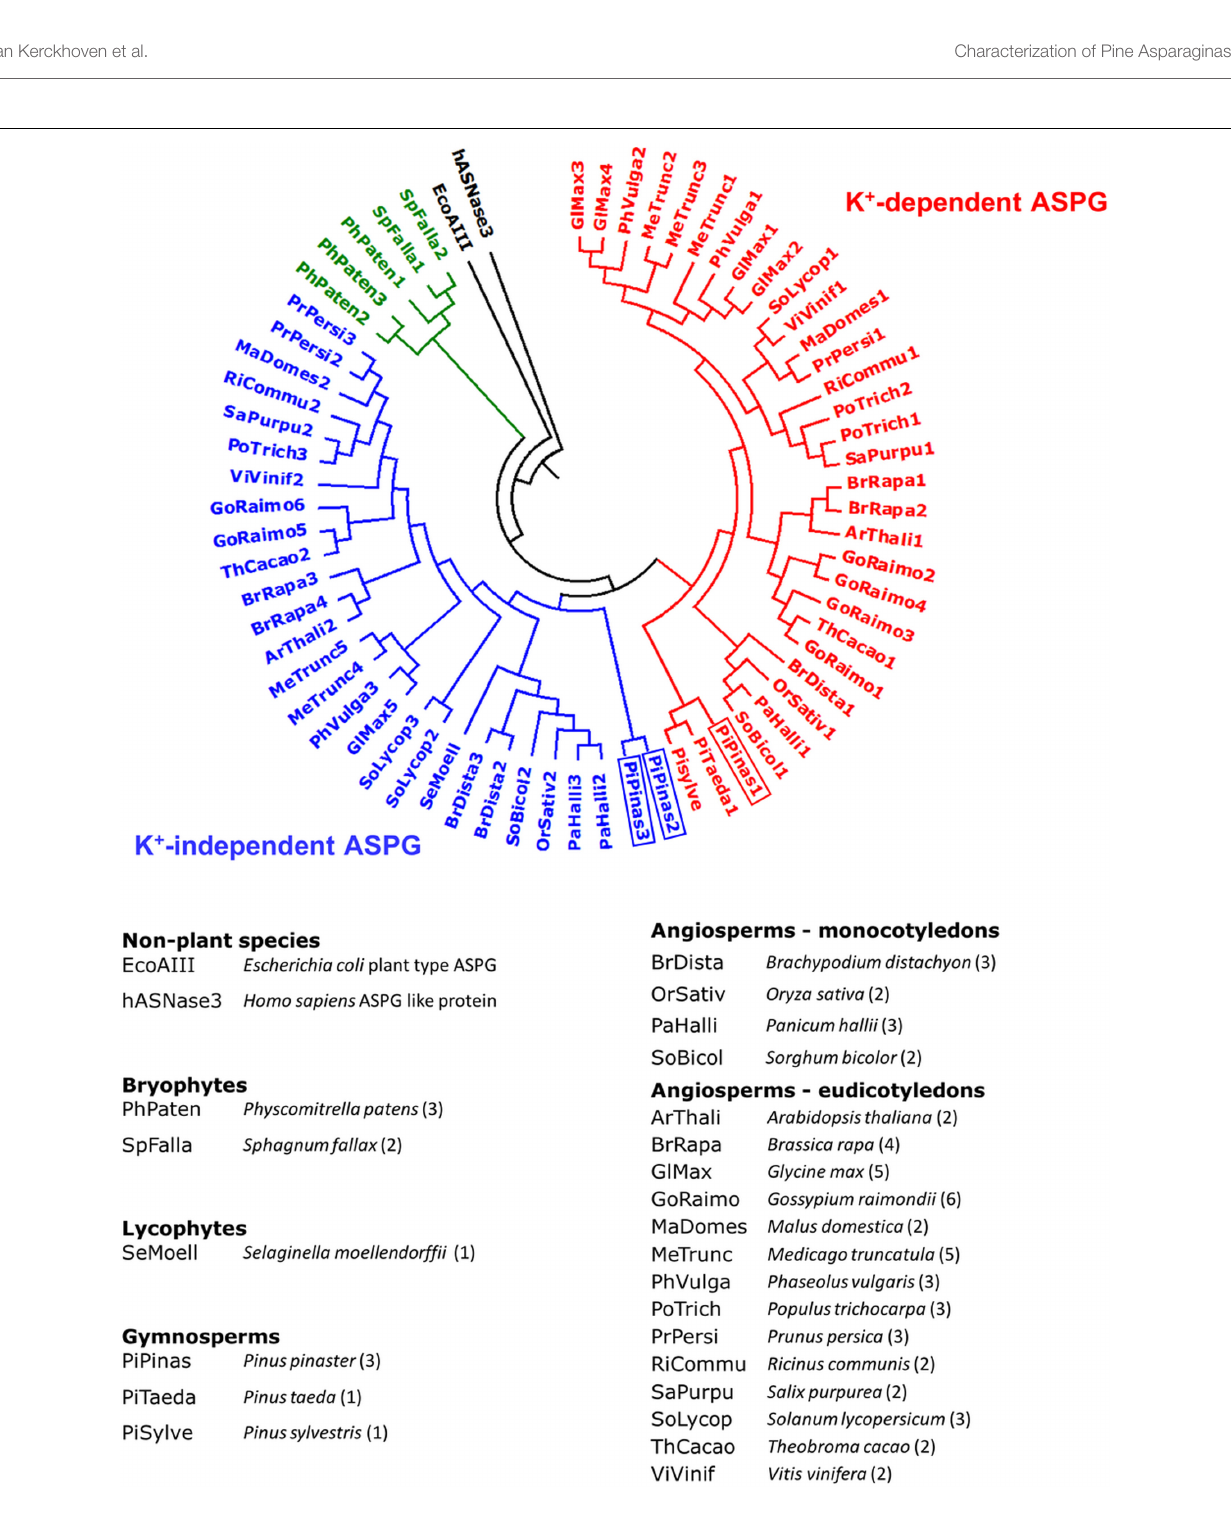
FIGURE 1 | Circular dendrogram of plant-type L -asparaginases. Plant species whose genomes have been sequenced were explored for ASPG coding genes and entries with the highest similarity to pine ASPG were selected. The plant-type ASPG from E. coli and a human ASPG-like protein were included as outgroups. Clustering of the complete amino acid sequences was based on neighbor-joining analysis using MEGA version 6 software (Tamura et al., 2013). A bootstrap consensus tree was inferred from 1000 replicates. Red branches contain K + -dependent ASPG, blue branches include K + -independent ASPG. ASPG from bryophytes are marked in green. Below the phylogenetic tree the species included in the analysis and their corresponding abbreviations are listed. The number of different ASPG that were included for each species is mentioned in brackets. P. pinaster asparaginases are framed in rectangles in the dendrogram.